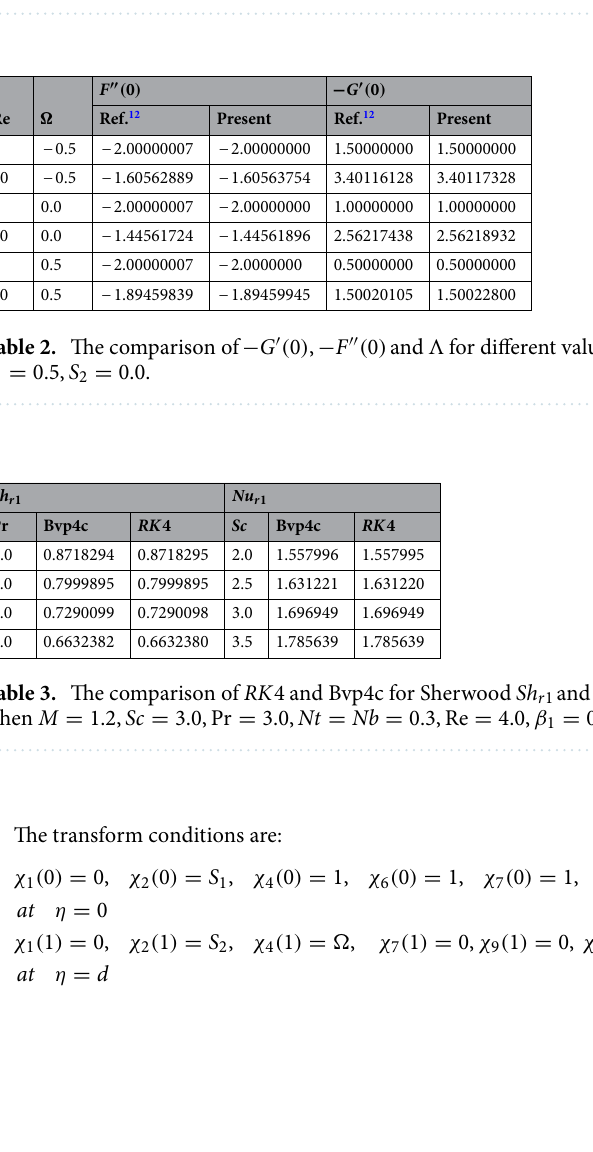
Table 1. For various valued of rotation parameter (cid:31) the comparison of − G ′ ( 0 ) , − F ′′ ( 0 ) and (cid:31) has been shown for the case when S 2 = S 1 = 0.